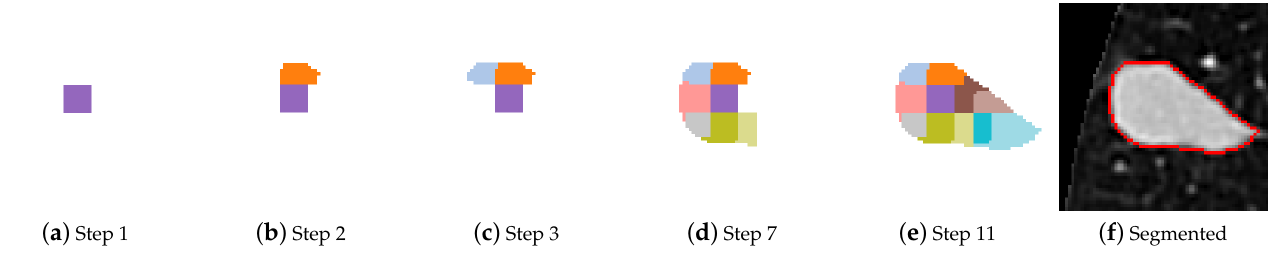
Figure 7. Merging of clusters, with a step